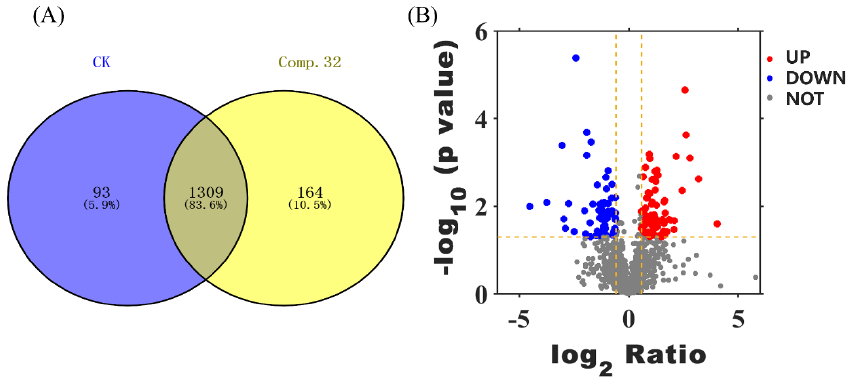
Figure 8. Venn diagram ( A ) and volcano plot ( B ) for proteins identified in the treatment and control groups.